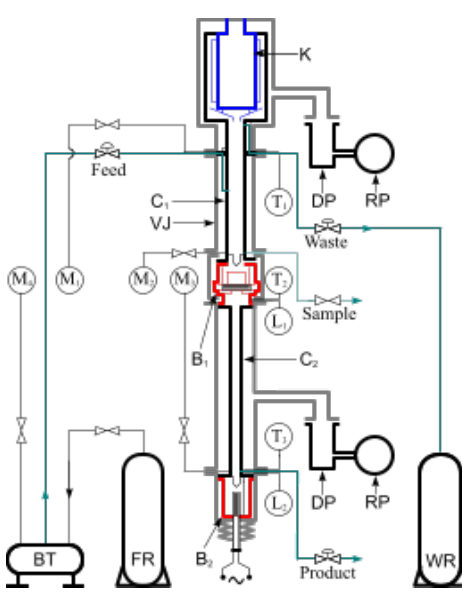
Figure 1. Isotope-separation column scheme, with condenser K, primary column C1, final column C2, reboilers B1–B2, vacuum jacket VJ, rough pump RP, diffusion pump DP, temperature sensors T1–T3, manometers M1–M4, level sensors L1–L2, feed reservoir FR, buffer tank BT, waste reservoir WR.